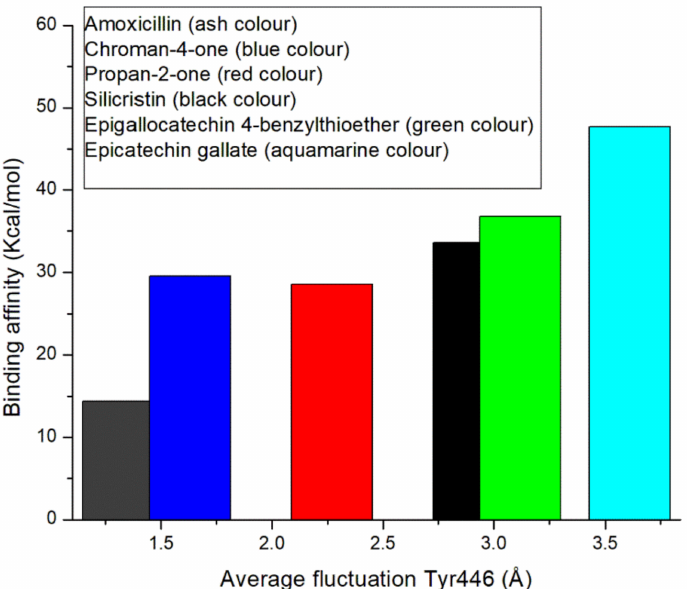
Figure 11. Correlation of the binding free energy of the top-five phenolics at the allosteric site of PBP2a and fluctuation of Tyr446 of PBP2a of S. aureus